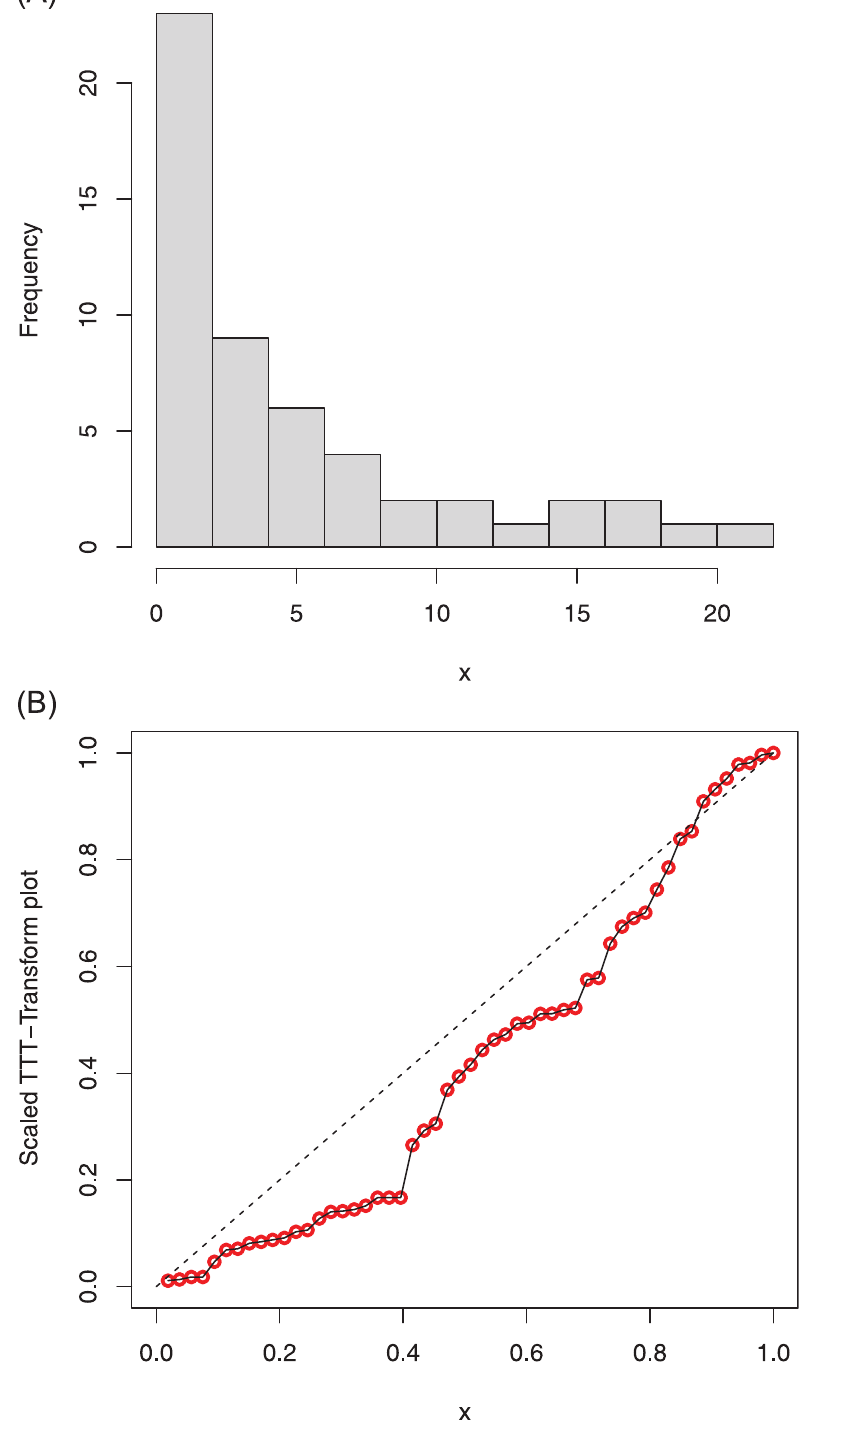
Fig 13. Histogram and TTT plot of the COVID-19 data 1.